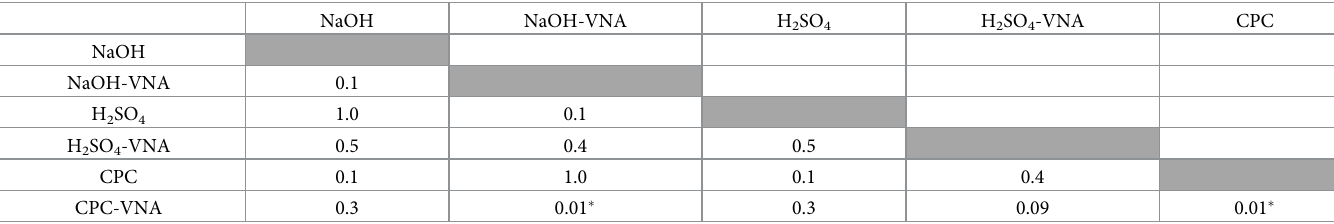
Table 1. P-values obtained by comparing six cultures procedures for the growth of M . avium subsp avium from spiked fecal cultures. NaOH NaOH-VNA H 2 SO 4 H 2 SO 4 -VNA CPC